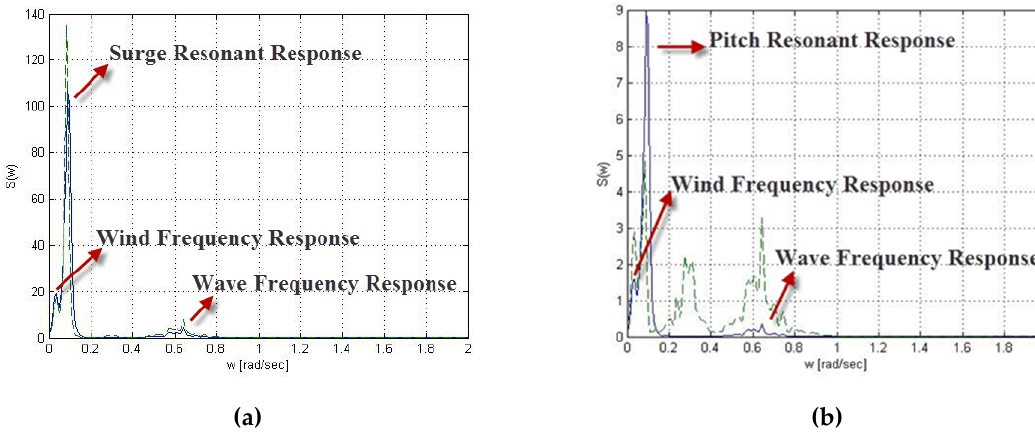
Figure 11. Platform response spectra of SWAY swivel and reference hinged model Case 2. (Solid blue: swivel model; Dash green: hinged model): ( a ) Surge. ( b )